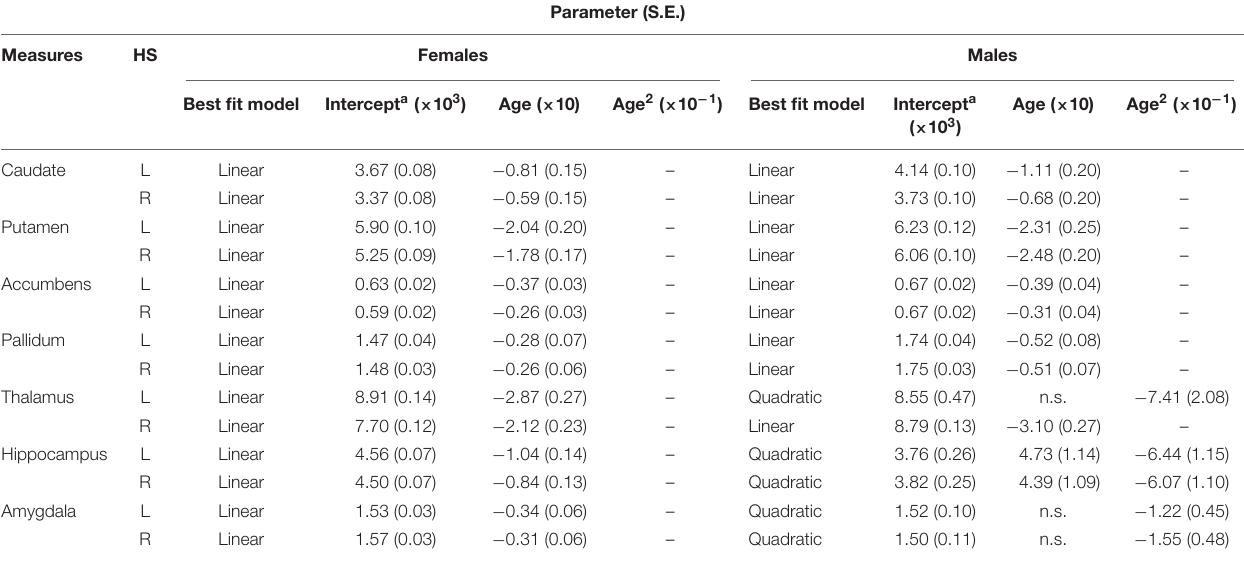
TABLE 4 | Fitting parameters for subcortical volumes versus age within each hemisphere in females and males.